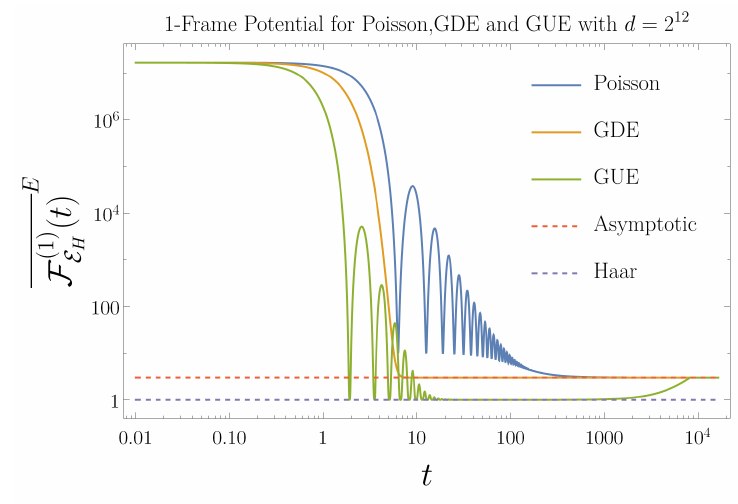
Figure 3: Log-Log plot of the ensemble average of frame potential for the Poisson, GUE and GDE ensemble with system size d = 2 12 . The dashed lines represent the Haar value 1 and the asymptotic value 3 + O ( d − 1 ) . While Poisson and GDE never go below the asymptotic value, GUE stays at the Haar value for the time window t ∈ [ O ( d 1 / 3 ) , O ( d )] and at late times t ≥ O ( d ) GUE moves away from the Haar value [ 103 ] and reaches the asymptotic value. This plot is already shown in [ 1 ] and reported here for